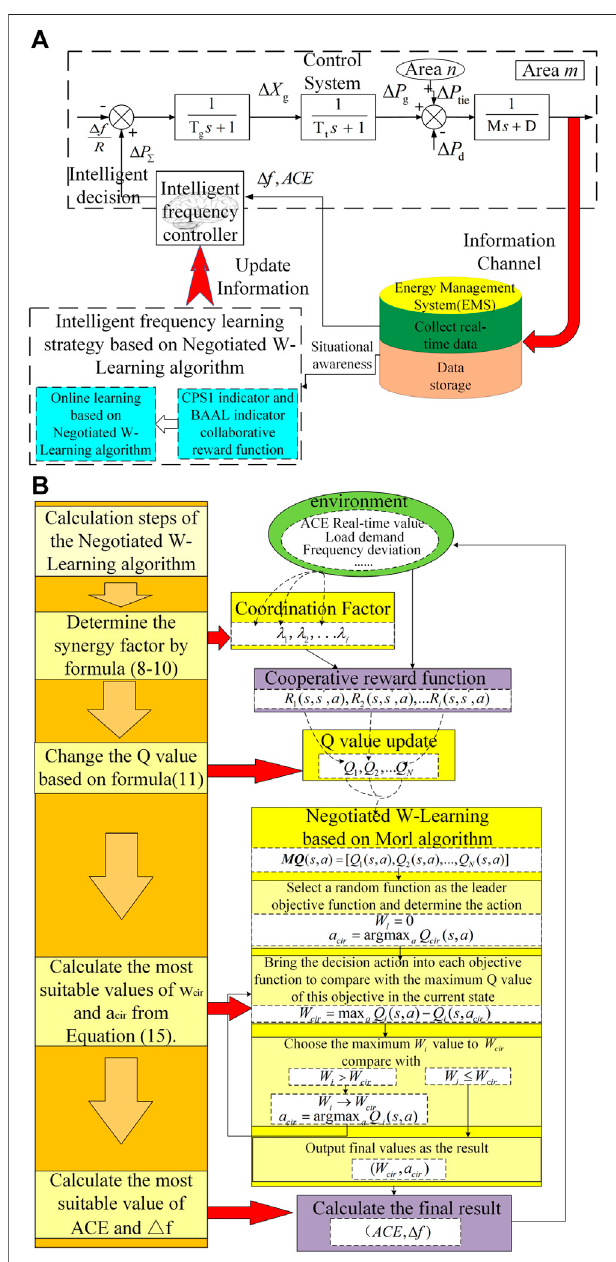
FIGURE 2 | Intelligent AGC control strategy: (A) Intelligent AGC control strategy for collaborative evaluation of multi-scale standards, (B) The framework of Negotiated